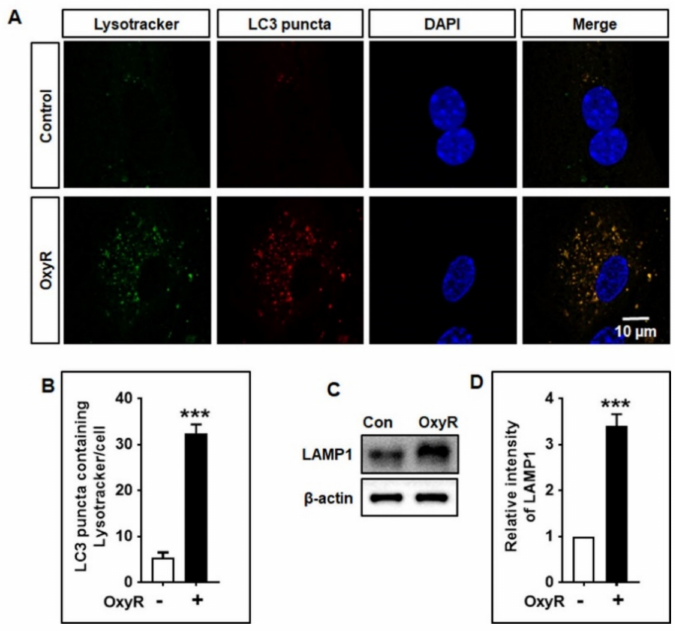
Figure 5. OxyR promoted autophagosome–lysosome fusion in astrocytes. ( A ) After 24 h of OxyR treatment, LysoTracker Green-HCK-123 was added and the culture was maintained at 37 ◦ C for 2 h before fixation. ( B ) From each slide, 3 random areas were selected and the number of LC3 puncta containing LysoTracker was counted in each and analyzed using one-way ANOVA. ( C ) LAMP1 expression levels were quantified using Western blotting. ( D ) Statistical significance was revealed by one-way ANOVA. Data are presented as mean ± SEM. *** p < 0.001. OxyR, oxyresveratrol; LC3, microtubule-associated protein light chain 3; DAPI, the nuclear marker 4 (cid:48) ,6-diamidino-2- phenylindole; LAMP1, lysosomal-associated membrane protein